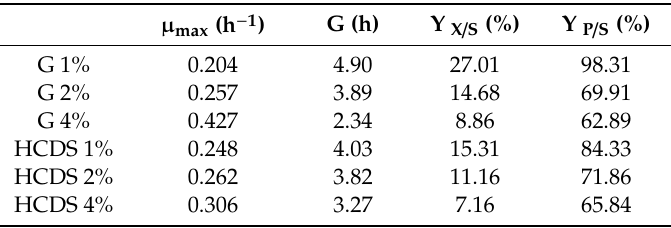
Table 2. Fermentation characteristics. µ max represents the maximal specific growth rate, G represents the generation time, Y X / S and Y P / S represent the yield coe ffi cients of the mass of cells or product formed per unit mass of substrate consumed, respectively. G 1%, G 2%, and G 4% represent respectively the concentrations of commercial glucose used as control for ethanol production. HDSC denotes hydrolyzate of date seed